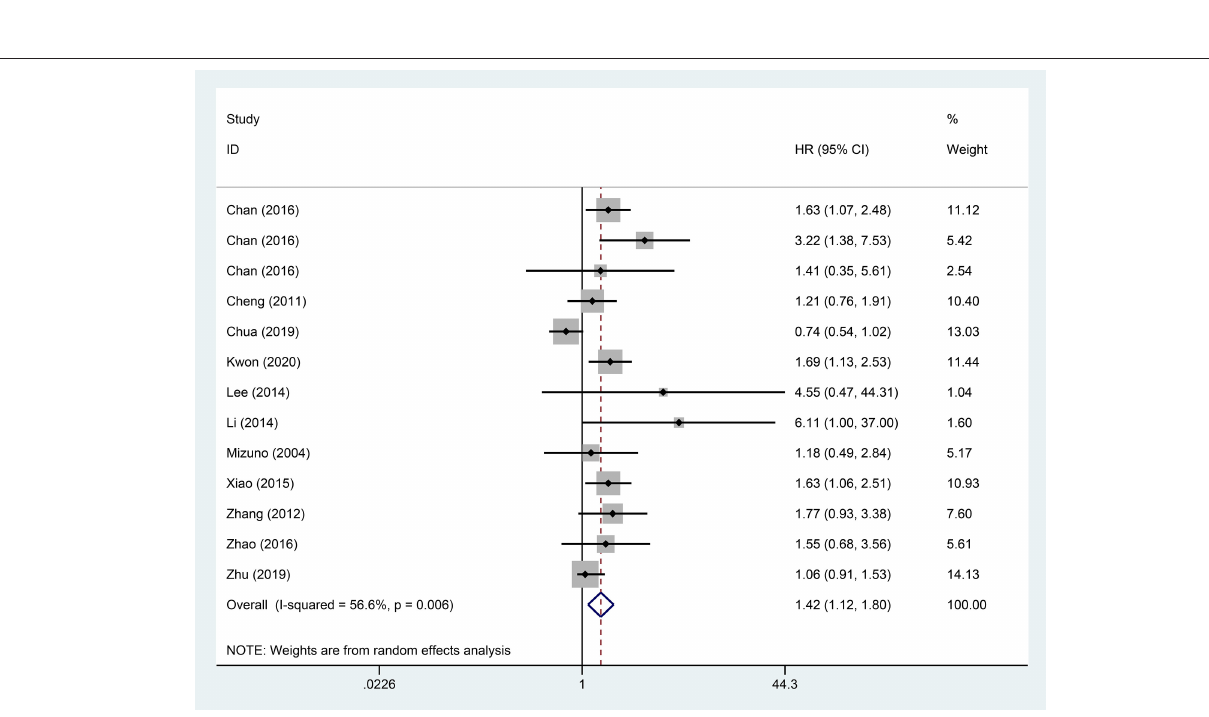
Frontiers in Surgery |